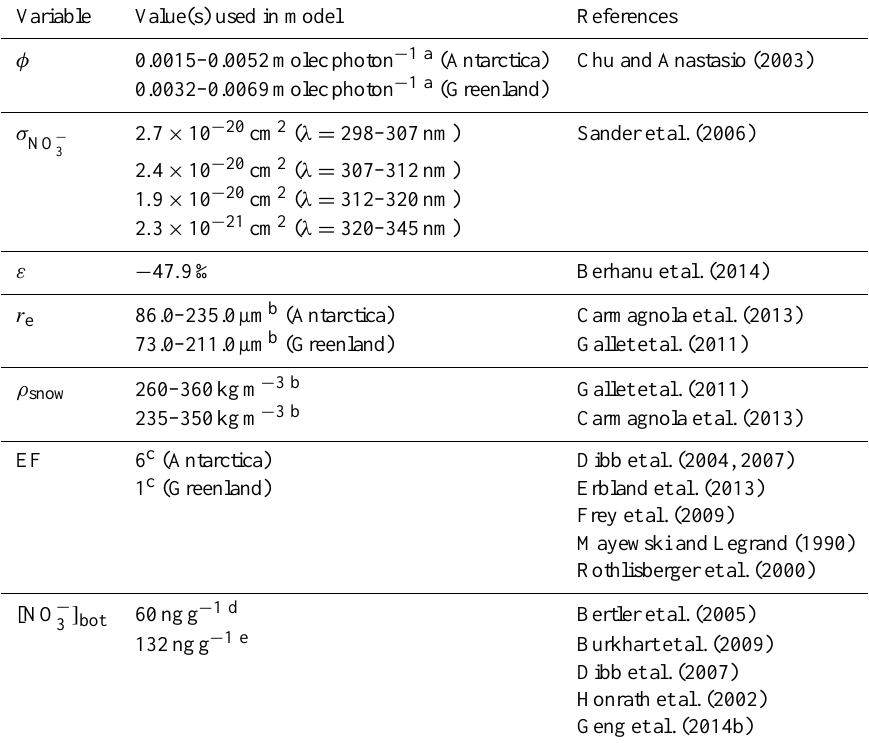
Table 2. Value(s) of parameters used in the